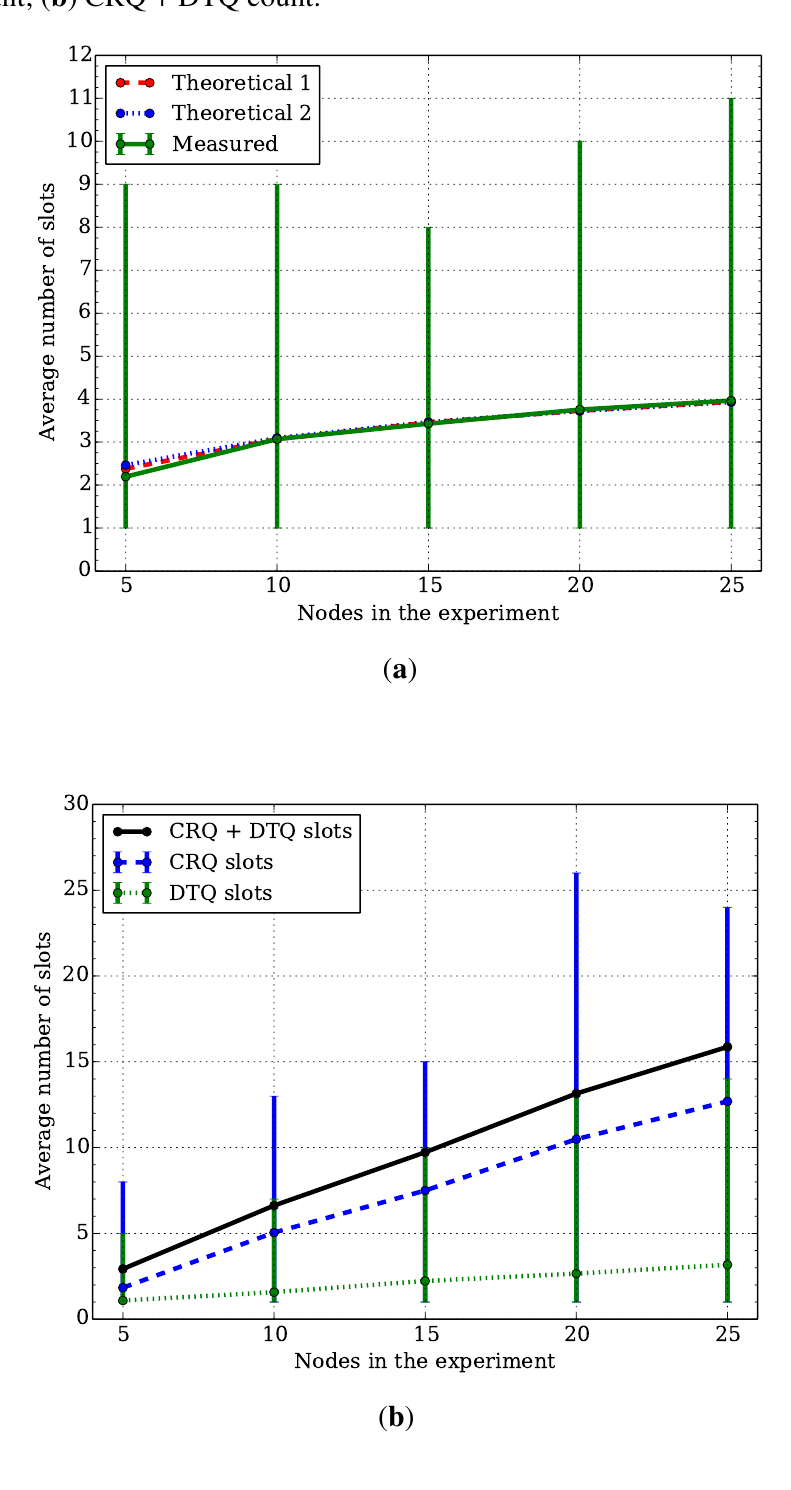
Figure 6. Average number of ARP and CRQ + DTQ in required to be able to transmit a data packet using Distributed Queuing (DQ). Each point is the average of 100 experiments and the error lines are the minimum and maximum values. The average number of ARP increases logarithmically, whereas the average number of CRQ + DTQ increases linearly. ( a ) ARP count; ( b ) CRQ + DTQ